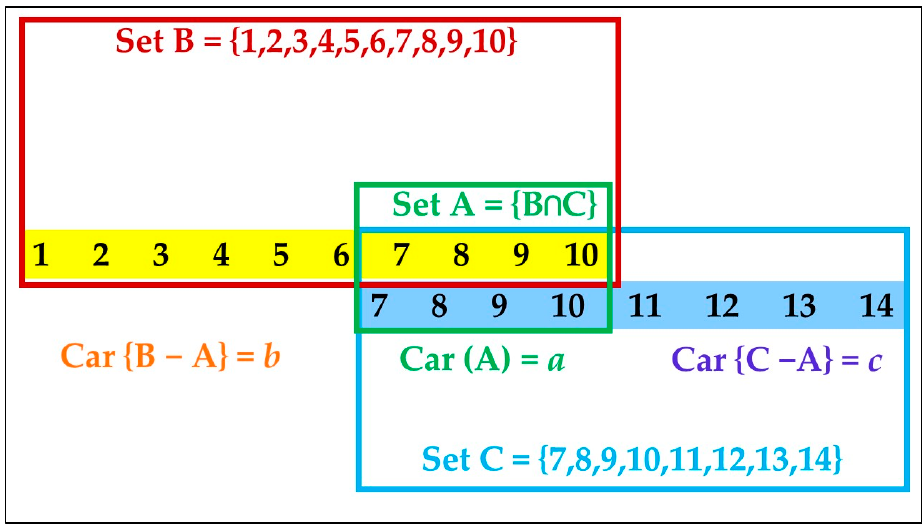
Figure 2. Basic generic example scheme of the data structure as applied in β -diversity and ζ -diversity formulae. The hypothetical example considers two neighbor sites including 10 and eight species, respectively.